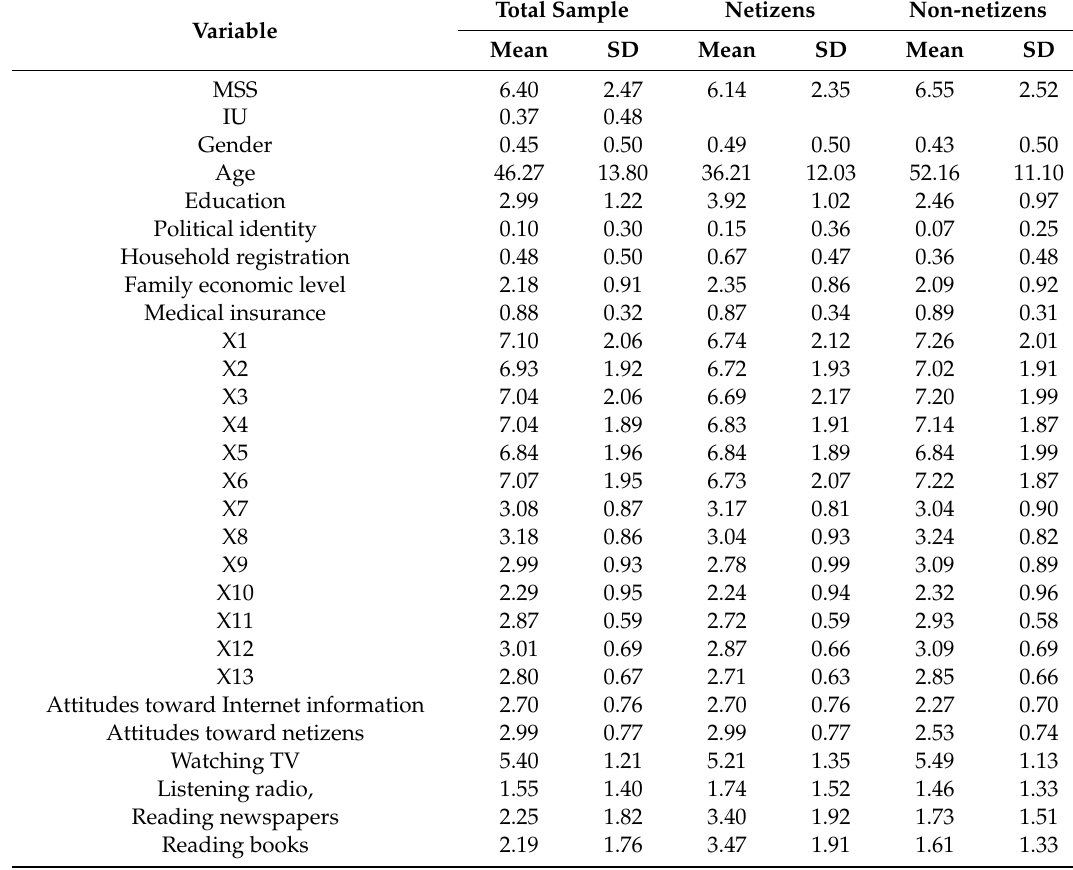
Table 2. Descriptive statistics of the main